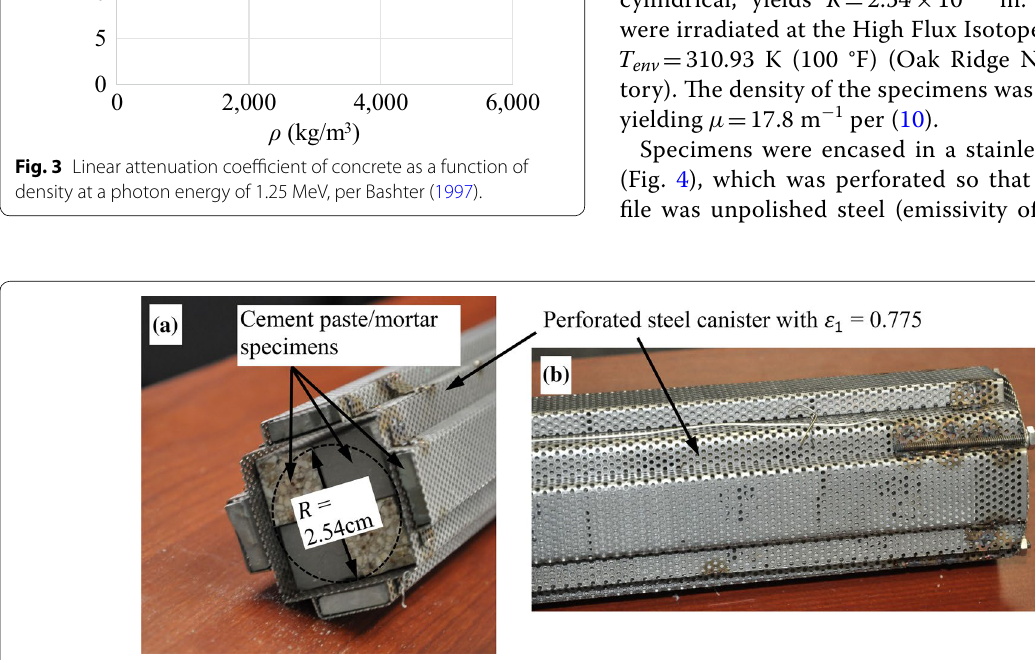
Fig. 4 Irradiation setup used in Linton et al. (2018) and Sanchez et al. (2018) in a profile view and b side view. Pictures courtesy of Deichert et al. (2017). For modeling purposes, the square geometry is modeled as quasi-cylindrical with a radius of 2.54 cm.